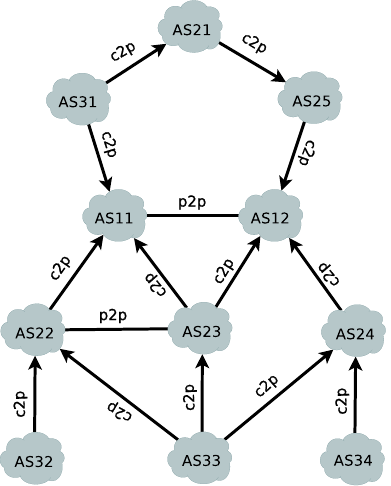
Figure 1: An illustrative AS-level Internet topology map consisting of 11 ASes (clouds) and 15 relations (links) among